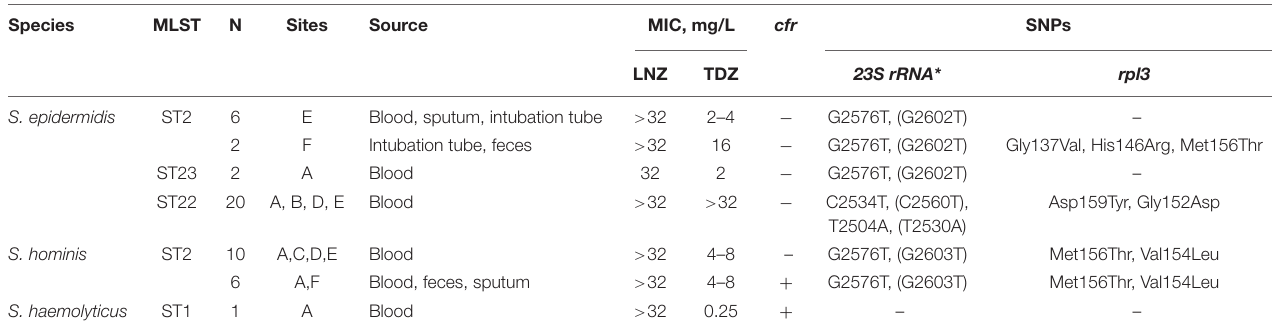
TABLE 1 | Characterization of Oxazolidinone-resistant CoNS isolated in Moscow hospitals. Species MLST N